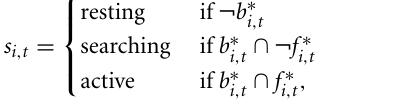
Figure 2 , we divided the architecture into levels (using vertical black lines). These levels embody a hierarchy in the processing of information. Feedforward connections are made from units in lower levels to units in higher levels while the reverse is true for feedback connections. Here, the number of levels depicted is